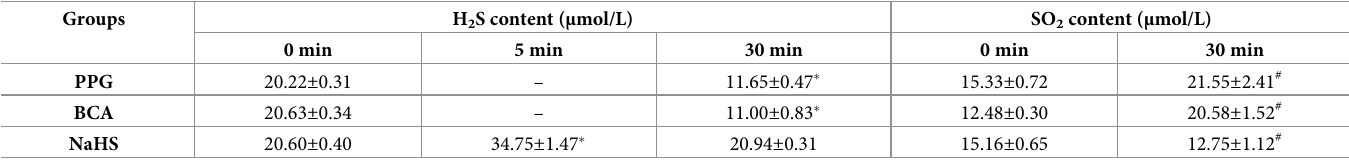
Data expressed as mean ± SEM; n = 8 in each group; paired-sample t-test � P < 0.05 compared with the plasma H 2 S content of rats before treatment in the corresponding group # P < 0.05 compared with the plasma SO 2 content of rats before treatment in the corresponding group. PPG, DL-propargylglycine; BCA, β -cyano-L-alanine; NaHS, sodium